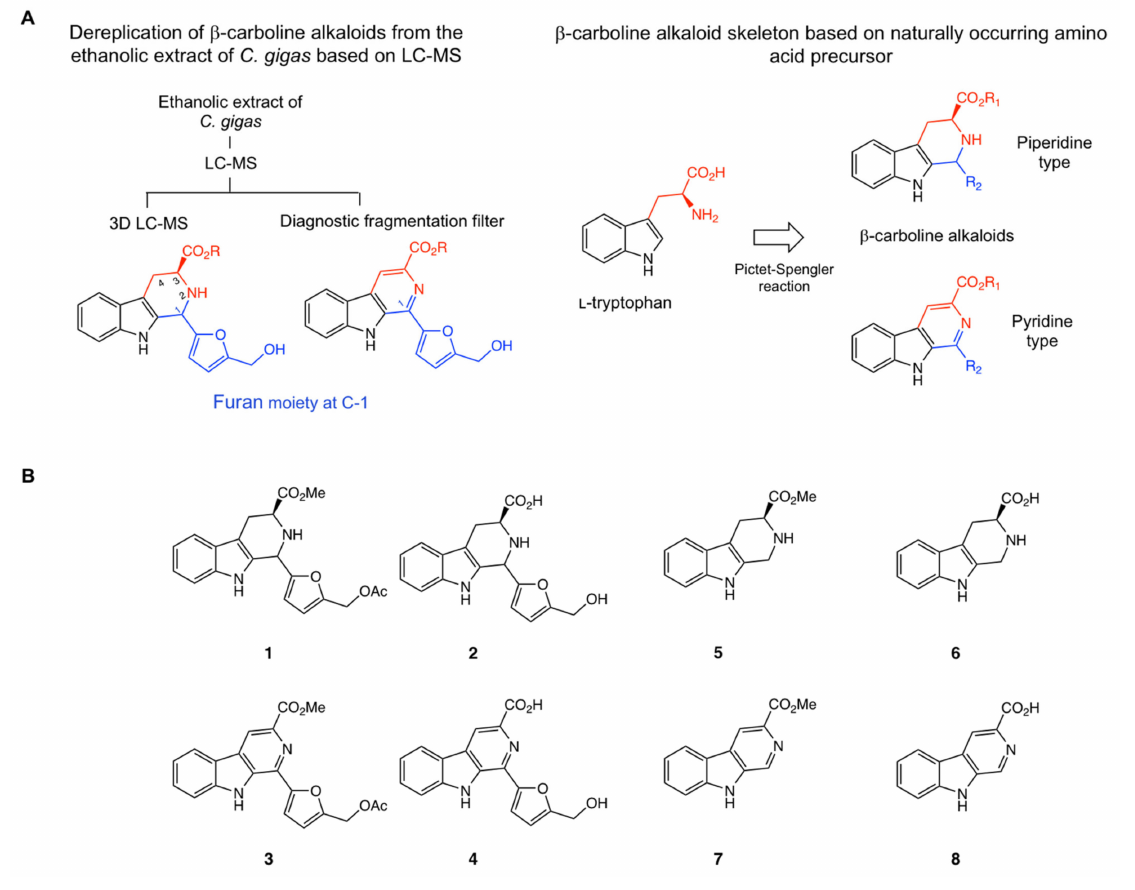
Figure 1. ( A ) Dereplication strategy of β -carboline alkaloids from Crassostrea gigas and design strategy for their structures; ( B ) Structures of designed β -carboline alkaloids 1 – 8